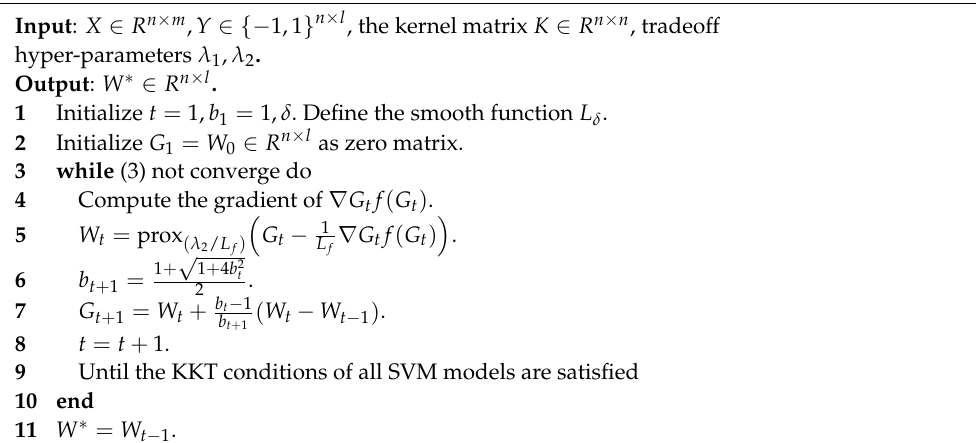
Algorithm 1: Accelerated Proximal Gradient Method for Equation